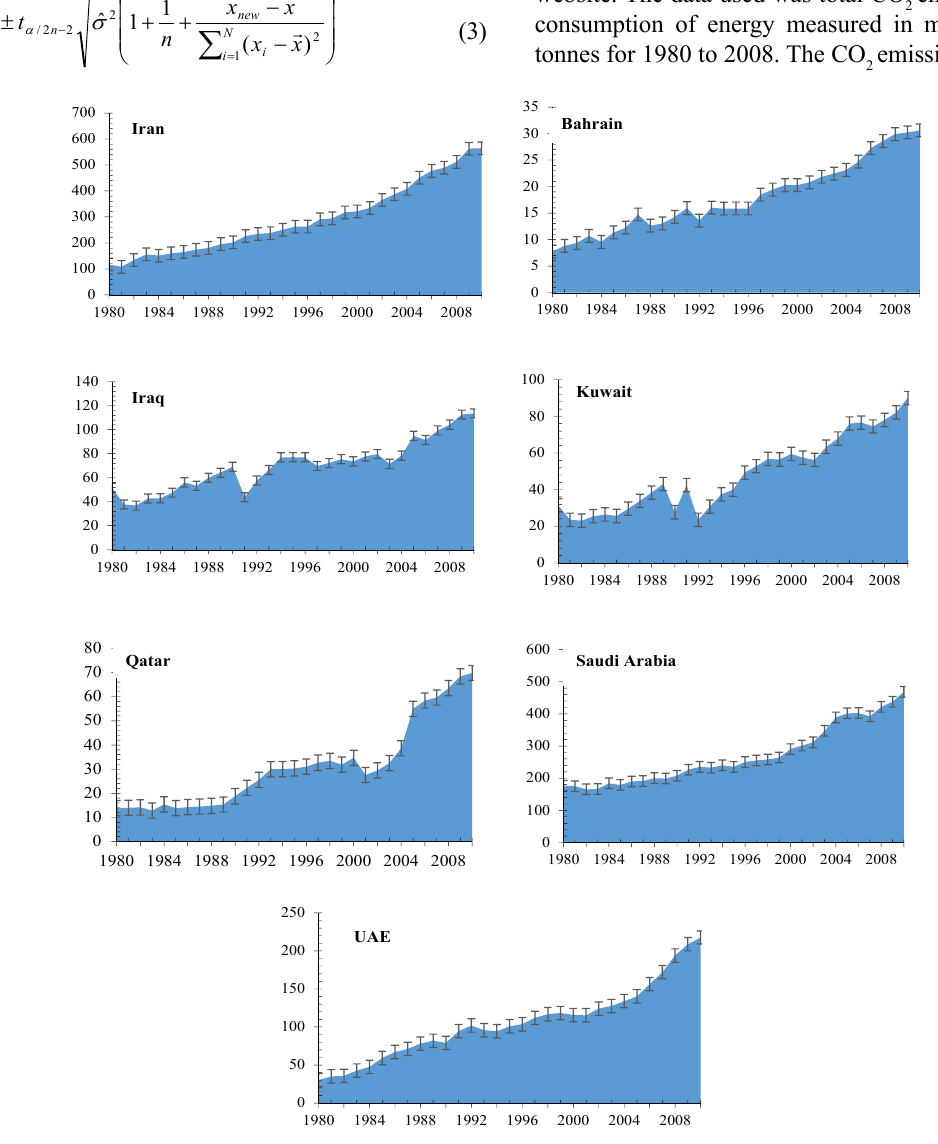
Fig. 2: Stacked area chart for Persian Gulf Countries CO 2 emissions during 1980-2008 (The vertical axis unit is CO emissions in Mtonnes and the horizontal axis is in year)